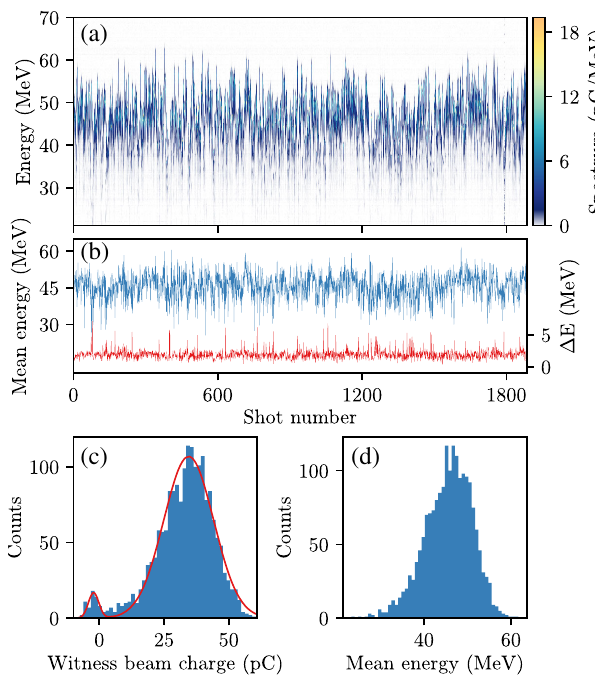
FIG. 3. (a) Waterfall plot of the witness-beam spectrum for 1885 consecutive shots. (b) The electron-beam mean energy (blue) and rms energy spread (red). (c) Histogram of the witness- beam charge, measured from the calibrated spectrometer screen with a double-Gaussian fit shown in red. (d) Histogram of the witness beam mean energy. Each histogram has 50 bins.